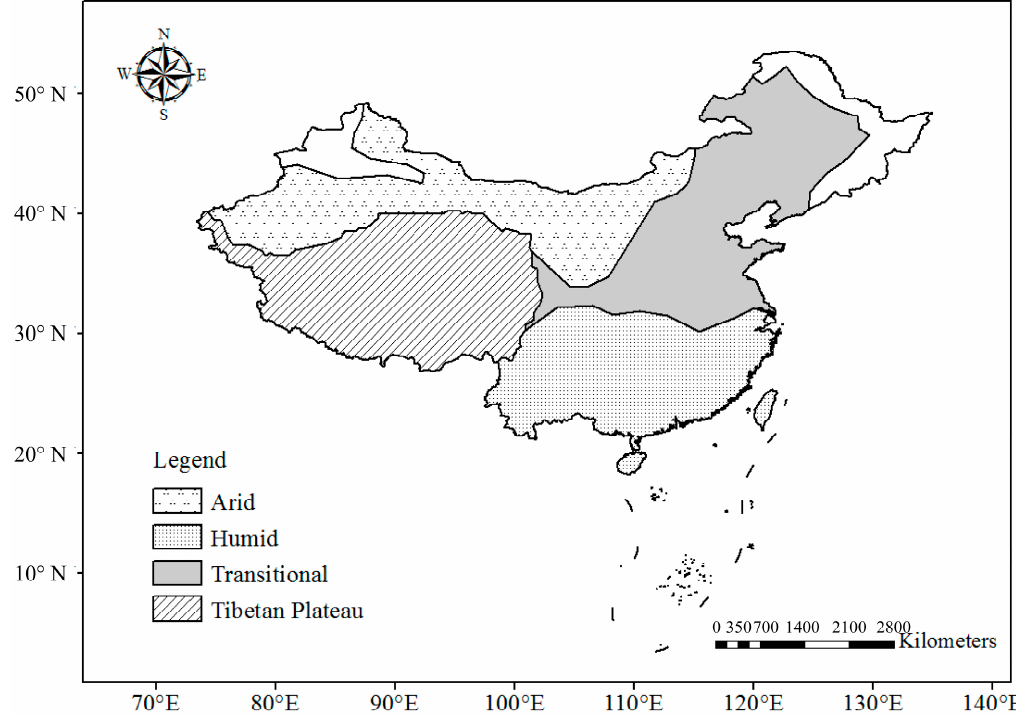
Figure 1. The typical climate regions of China (arid, humid, transitional, the Tibetan